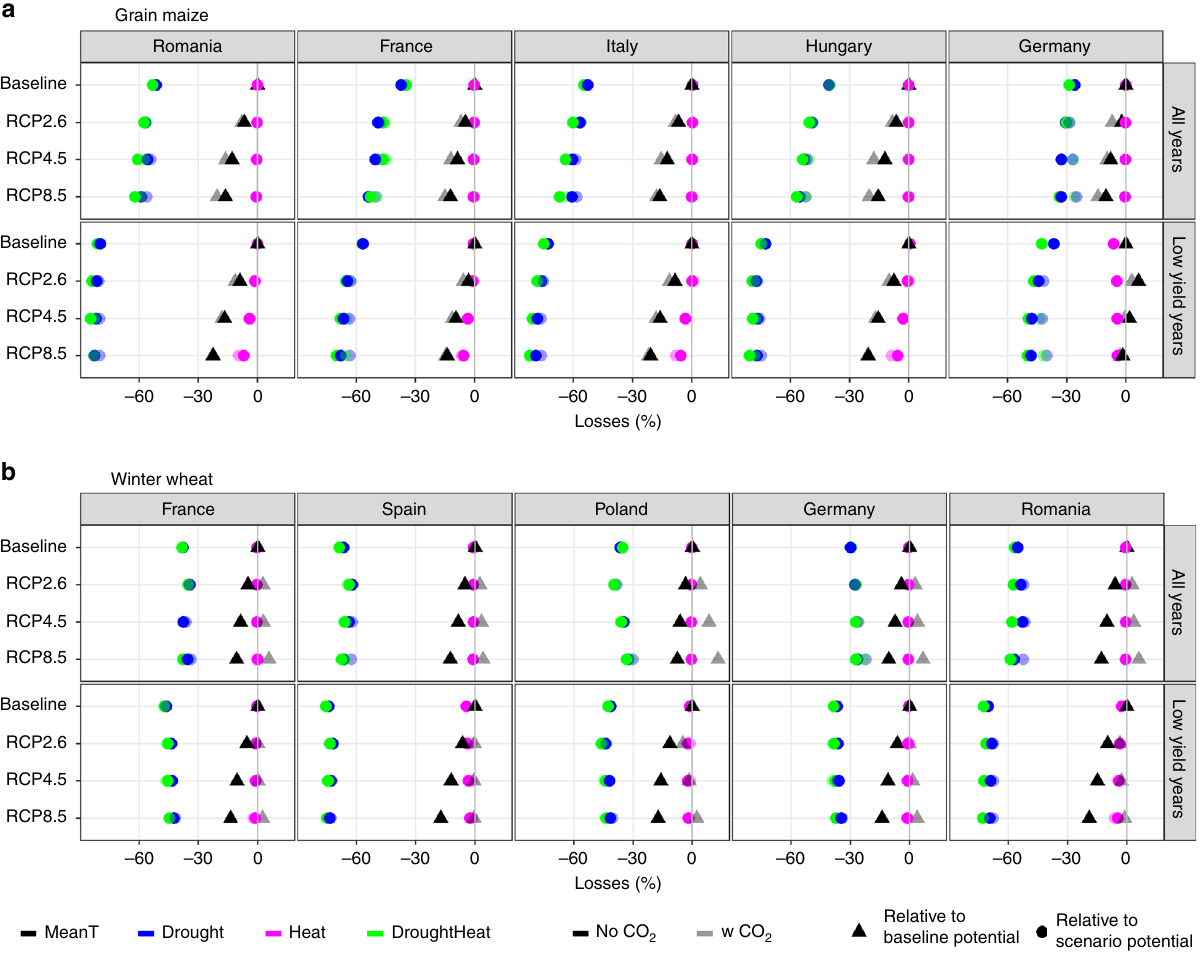
Fig. 3 Drivers of yield losses in average and low-yielding years for rainfed systems by country. Drivers of yield change in current baseline climate (1981 – 2010) and three climate scenarios (RCPs 2.6, 4.5, and 8.5) in the period 2040 to 2069 for a grain maize and b winter wheat. Drivers of yield levels are shown for the average of all years (top row in both panels), and drivers of yields levels for years with yields in the lowest decile (bottom row in both panels). The shape of the symbol indicates the period in which changes are expressed as relative to (triangles are for changes relative to the baseline potential and circles are losses relative to the respective scenario potential), whereas the color indicates the drivers considered (black are mean temperature effects, blue are drought, magenta is heat, and green is the combination of drought and heat). The change in potential yields resulting from the mean temperature effects are shown with black triangles for each scenario relative to the baseline potential. For the other drivers, changes indicated by circles are relative to scenario potential yield. In all cases, the shading indicates if CO 2 fertilization was considered (dark symbols consider CO 2 , light symbols do not consider CO 2 ). Results are shown for the fi ve countries with the largest production area in Europe for each crop, listed by